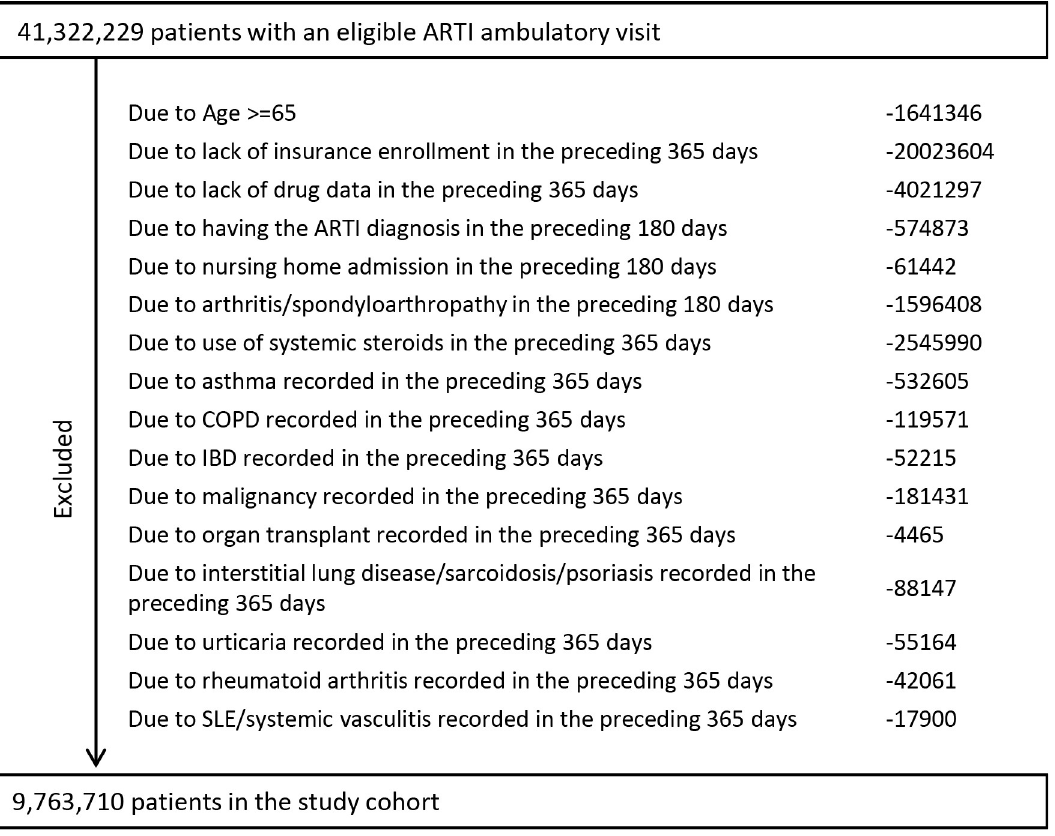
Fig 1. Study attrition